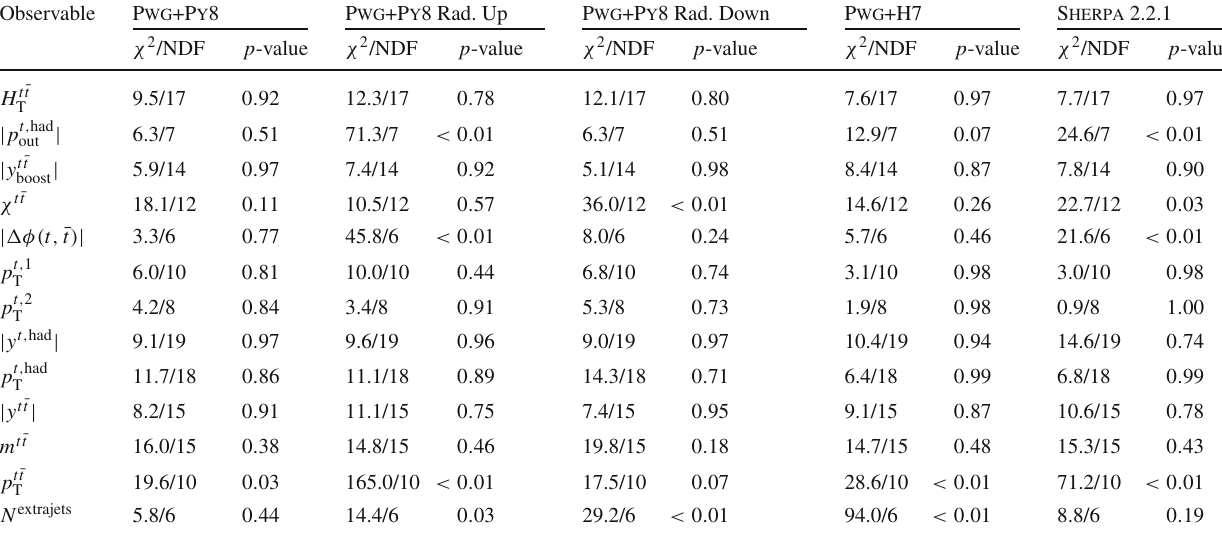
Table 9 Comparison of the measured particle-level normalised single- differential cross-sections in the resolved topology with the predictions from several MC generators. For each prediction a χ 2 and a p -value are